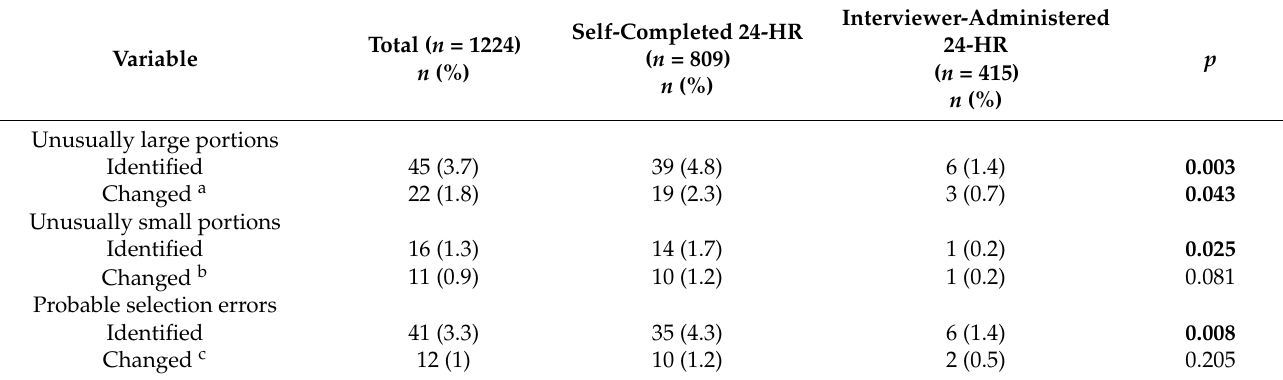
Table 4. Prevalence of 24-HRs containing unusually large portions, small portions and items likely to have been selected in error, by 24-HR completion method (self-completed and interviewer